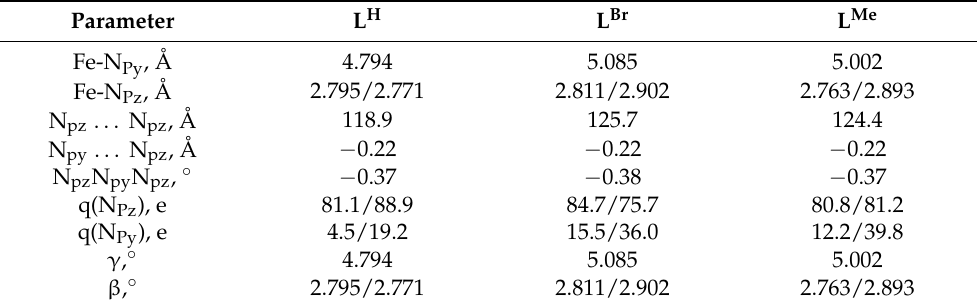
Table 4. Selected geometric parameters 1 and NBO charges of coordinating nitrogen atoms in the ligands L R as obtained from TPSSh/def2-TZVP